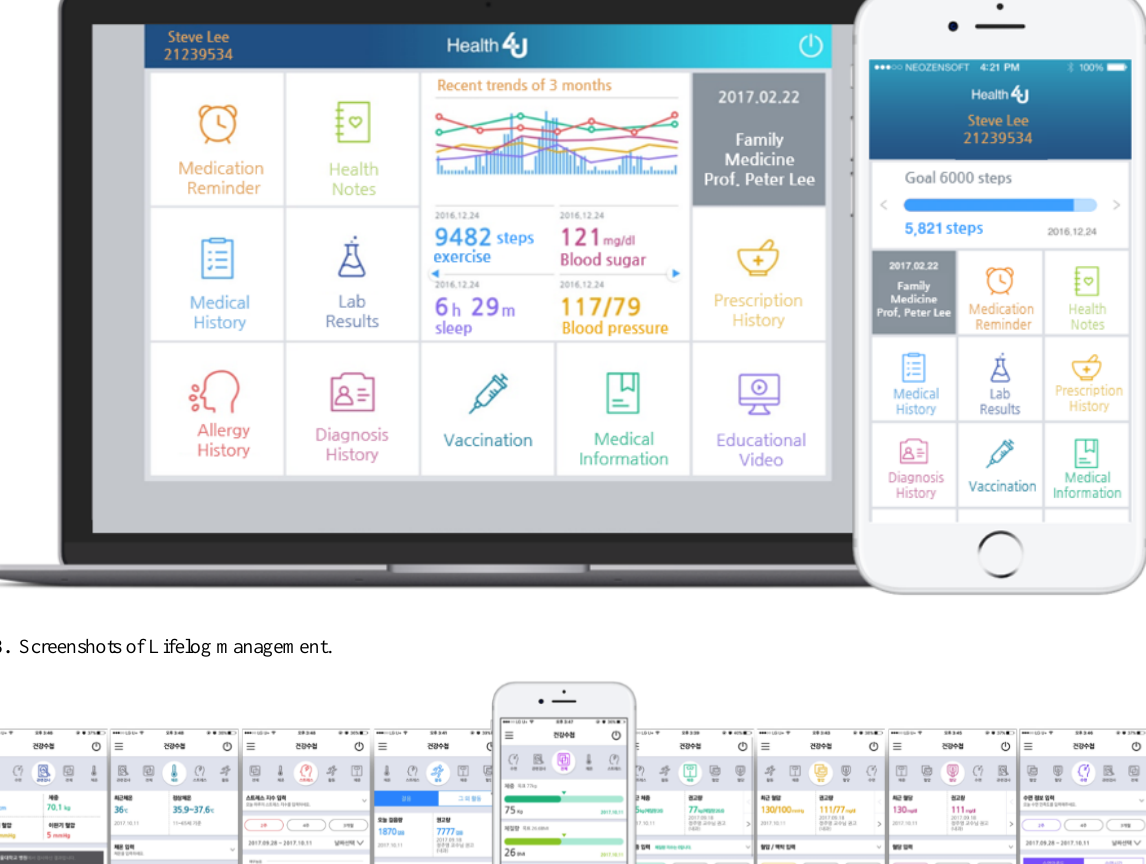
Figure 2. The Health4U app for personal computer and mobile phone.